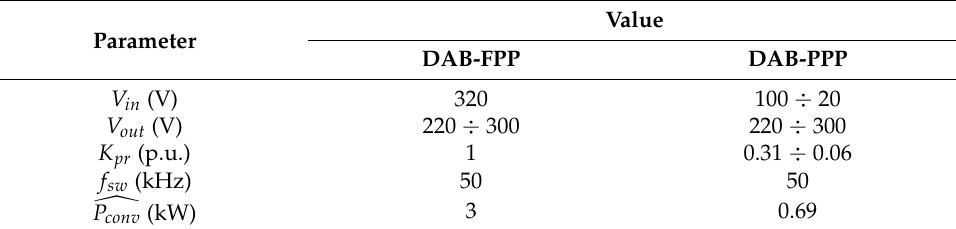
Table 3. Main electrical parameters of the DAB-FPP and DAB-PPP prototypes. Parameter